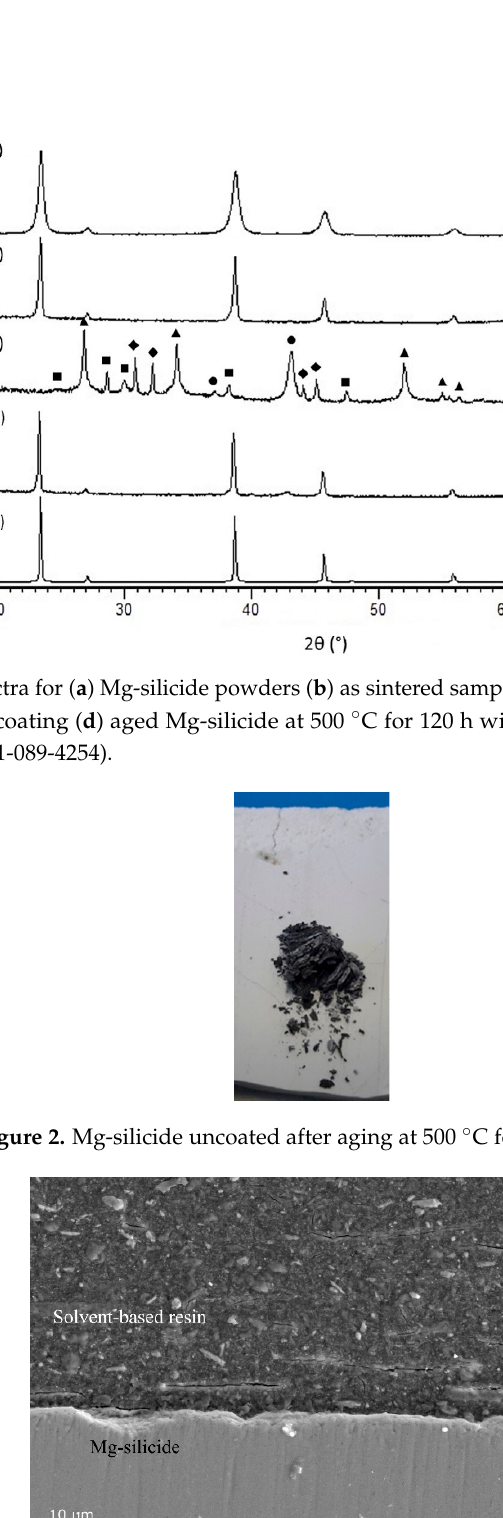
Figure 3. Cross sectional SEM image of coated sample after curing at 250 °C for 45 min under flowing Ar.